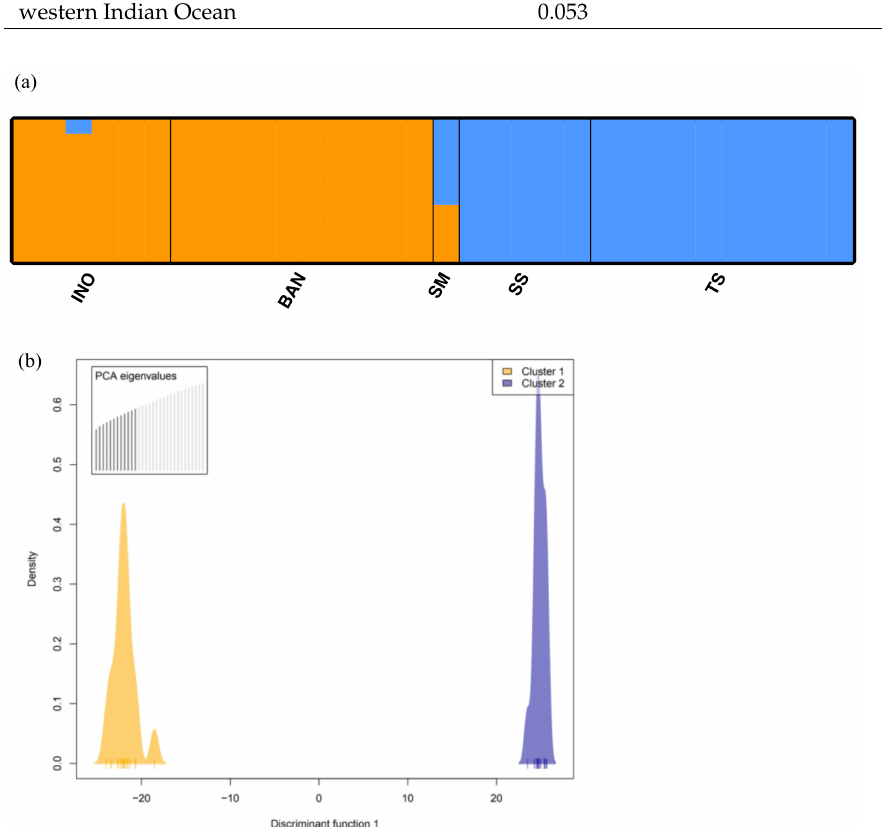
Figure 2. Cluster groupings based on SNP data for Pampus chinensis . ( a ) Two clustering groups ( K = 2) were suggested by STRUCTRUE analysis based on the highest delta K value. INO denotes the Indian Ocean population, BAN the Bay of Bengal population, SM the Strait of Malacca population, SS the South China Sea population and TS the Taiwan Strait population. ( b ) Two clustering groups represented by a single discriminant function in the DAPC analysis, cluster 1 including the individuals sampled from INO, BAN and SM, cluster 2 including the individuals sampled from SS and